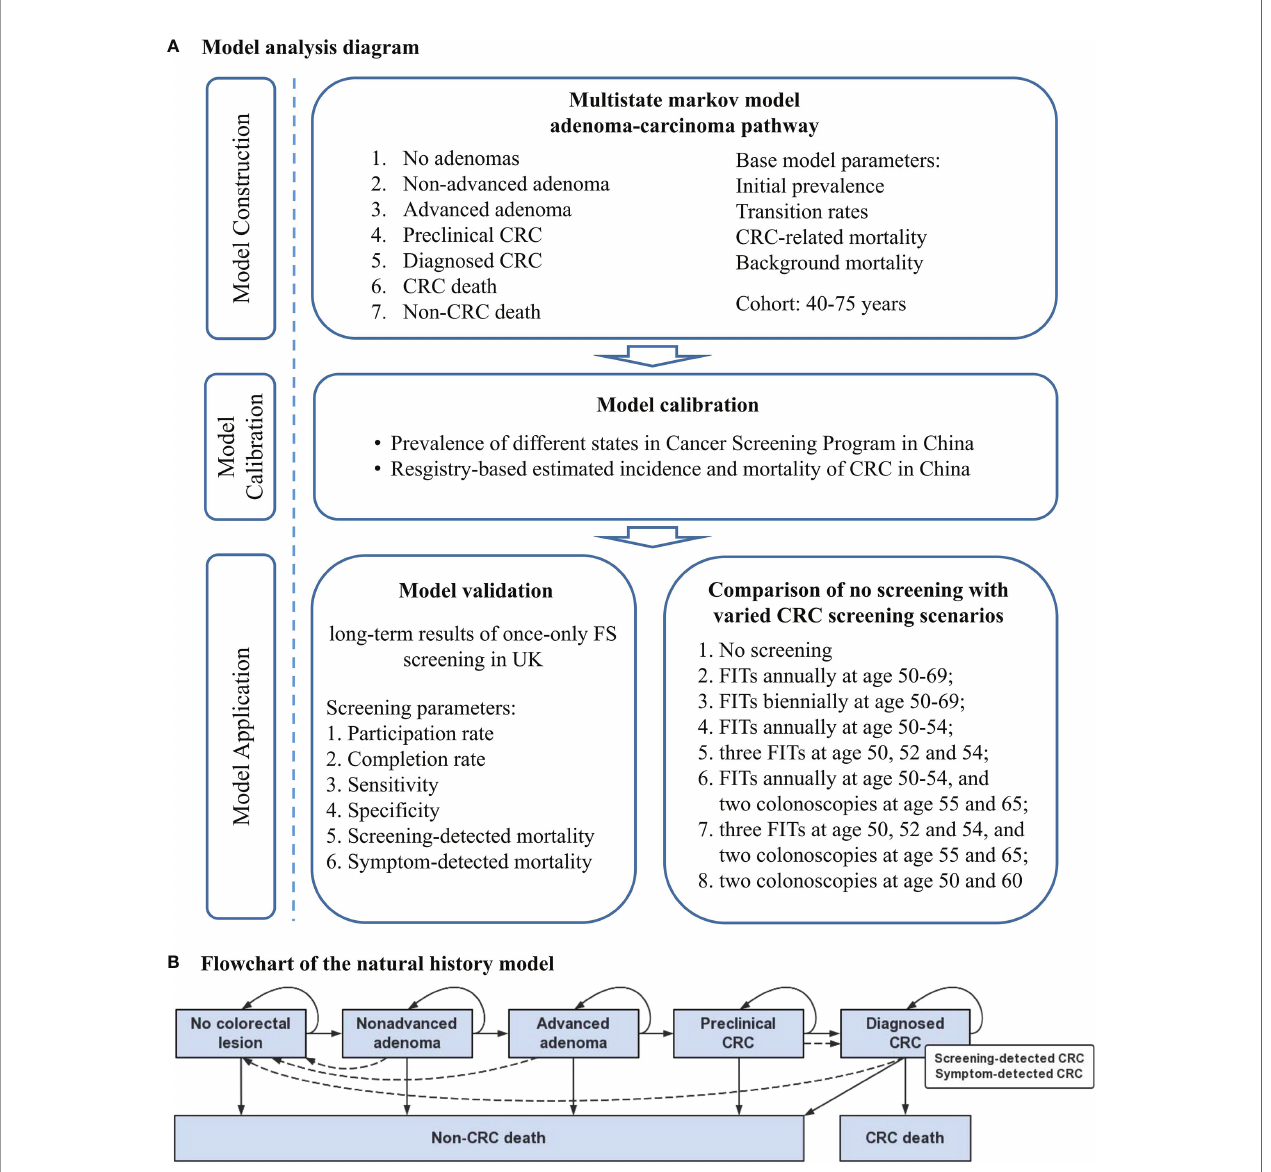
FIGURE 1 | Concept framework and analysis fl ow. (A) Model analysis diagram. (B) Flowchart of the natural history model for the adenoma-carcinoma sequence. Solid lines represent the progression of colorectal lesions through the adenoma-carcinoma sequence in the absence of screening; dashed lines show the movement between states because of the detection and removal of adenoma, the detection of asymptomatic colorectal cancer by screening or symptom, and the curation of colorectal cancer. CRC, colorectal cancer; FS, fl exible sigmoidoscopy; FIT, fecal immunochemical